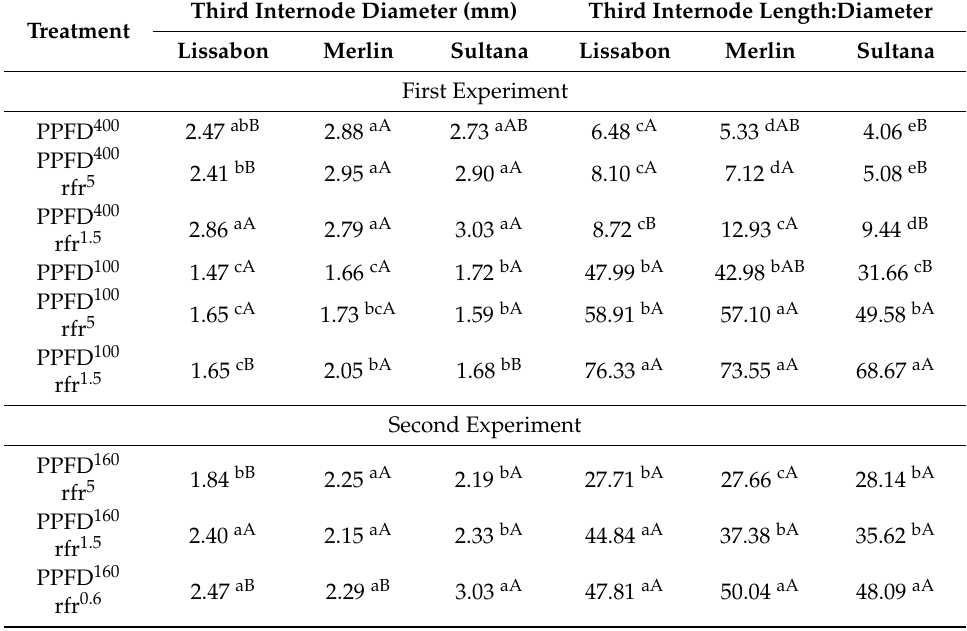
Table 4. The least square means of internode diameter for the three cultivars in the first (top) and second (bottom) experiment. For each experiment, lower case letters indicate significant di ff erences between treatments for each cultivar, and upper case letters indicate significant di ff erences between cultivars for each treatment ( p < 0.05). Third Internode Diameter (mm) Third Internode Length:Diameter Treatment Lissabon Merlin Sultana Lissabon Merlin Sultana First